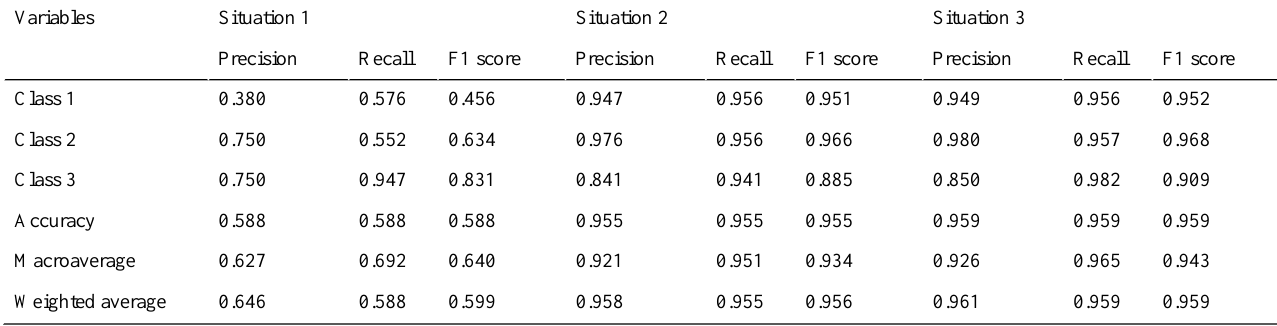
Table 2. The indicators of the